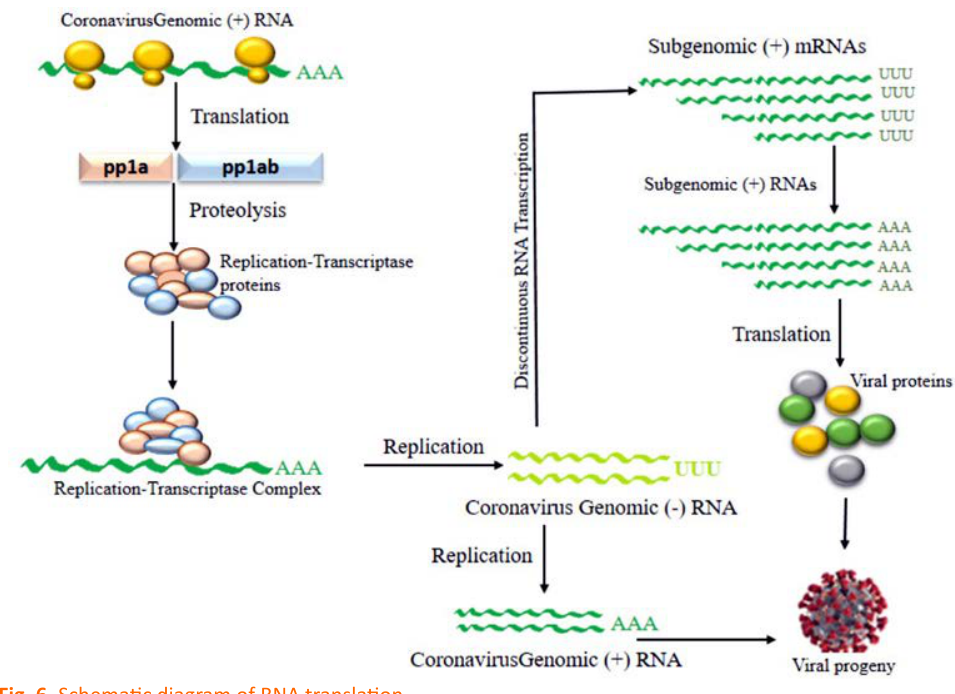
Fig. 6. Schematic diagram of RNA translation Proteolysis of pp1a and pp1ab forms replication-transcriptase complex (RTC) which is involved in replication of genomic RNA and viral proteins (S, M, E and N) encoded by discontinuous transcription forms a viral progeny Transcriptase proteins encoded in